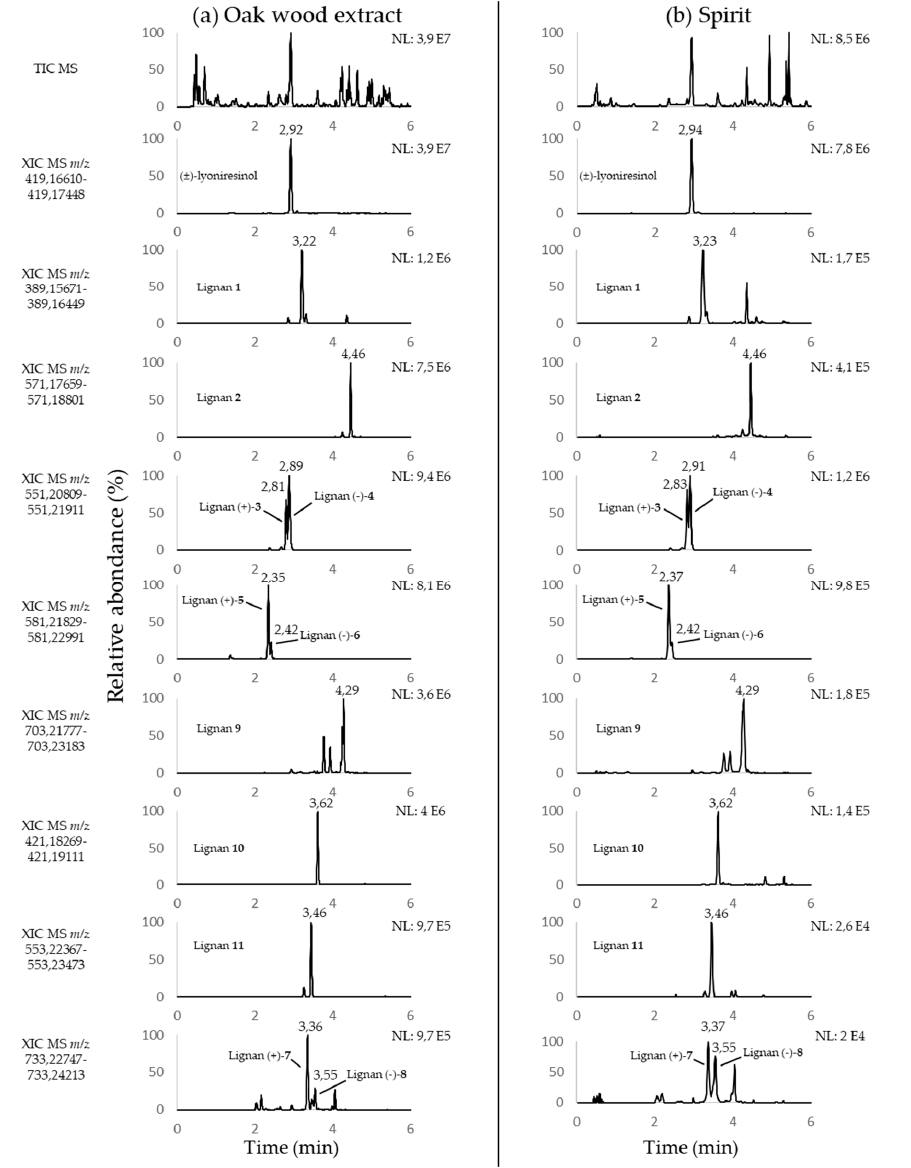
Figure 2. Negative LC-ESI-FTMS XIC of an ( a ) oak wood extract and ( b ) a spirit corresponding to [M − H] − ions of lyoniresinol and lignans 1 – 11 (from top to bottom).